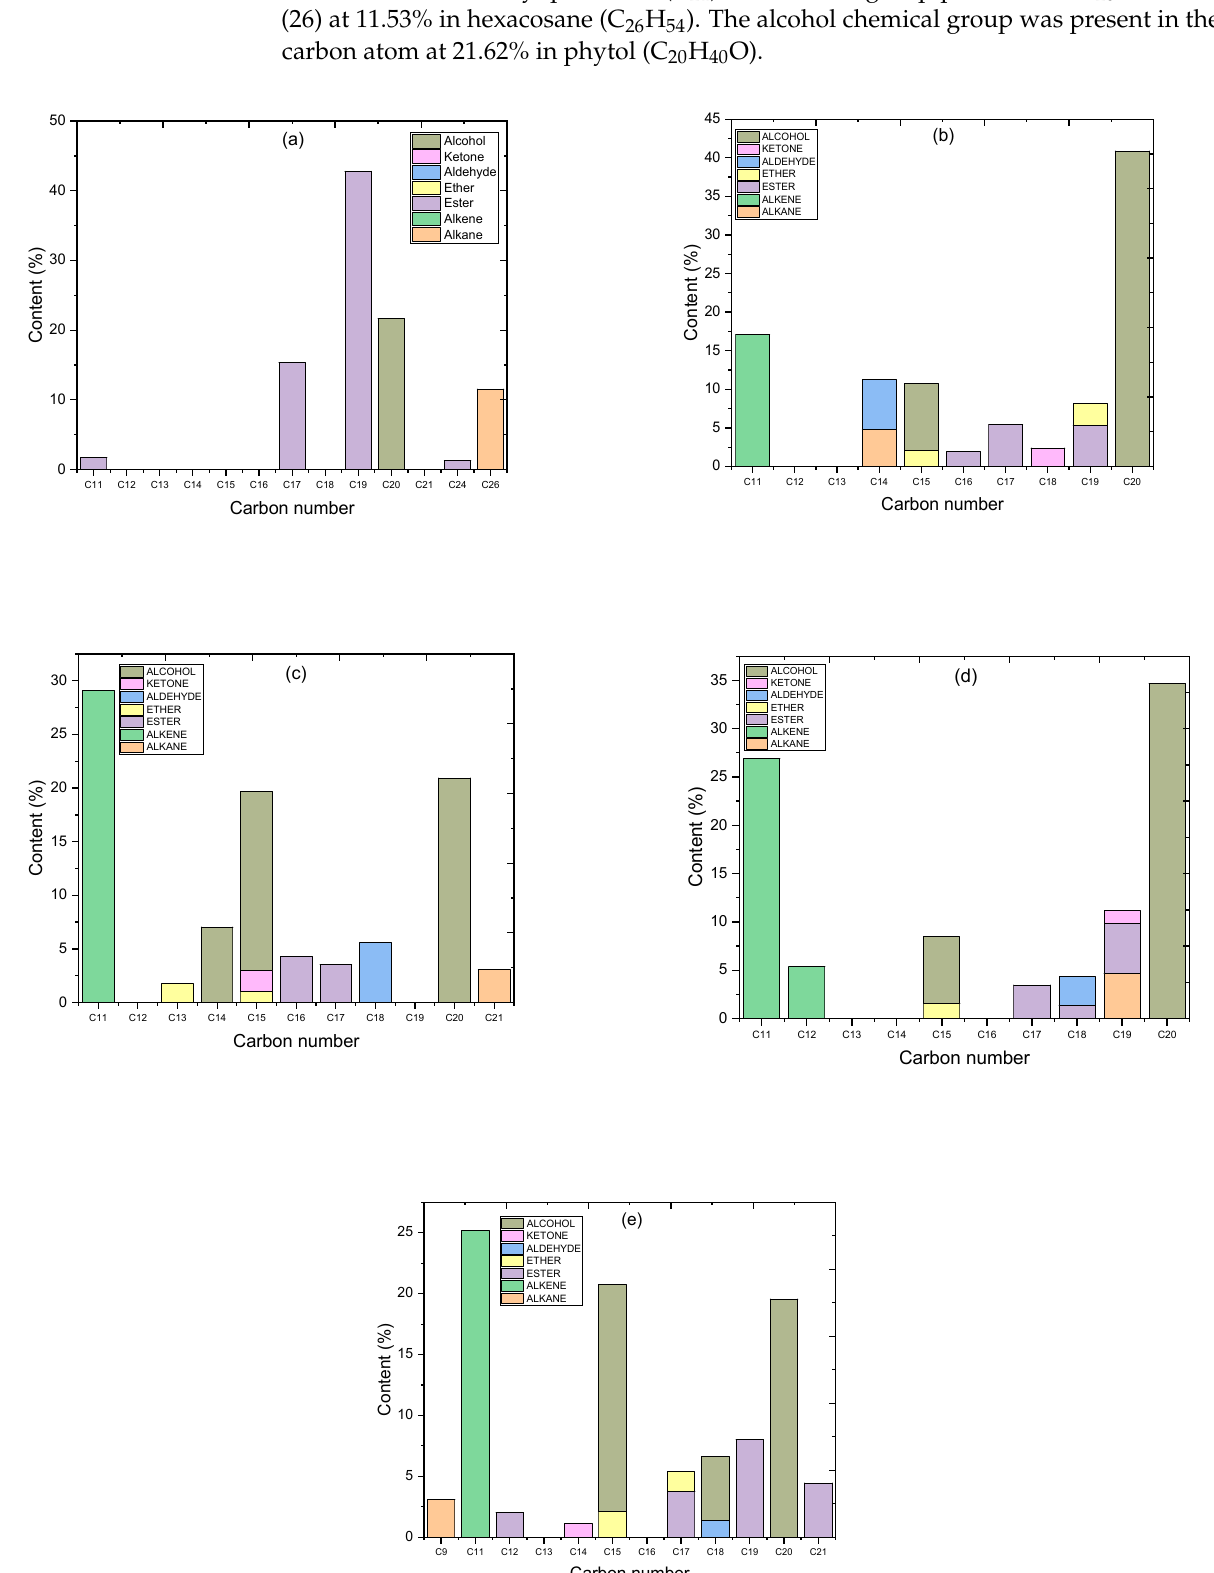
Figure 11. Carbon number distribution for the algal HO ( a ) and the products of the catalytic de- oxygenation of the HO over HZSM-5 ( b ), 5% La/HZSM-5 ( c ), 10% La/HZSM-5 ( d ), and 15% La/HZSM-5 ( e ).